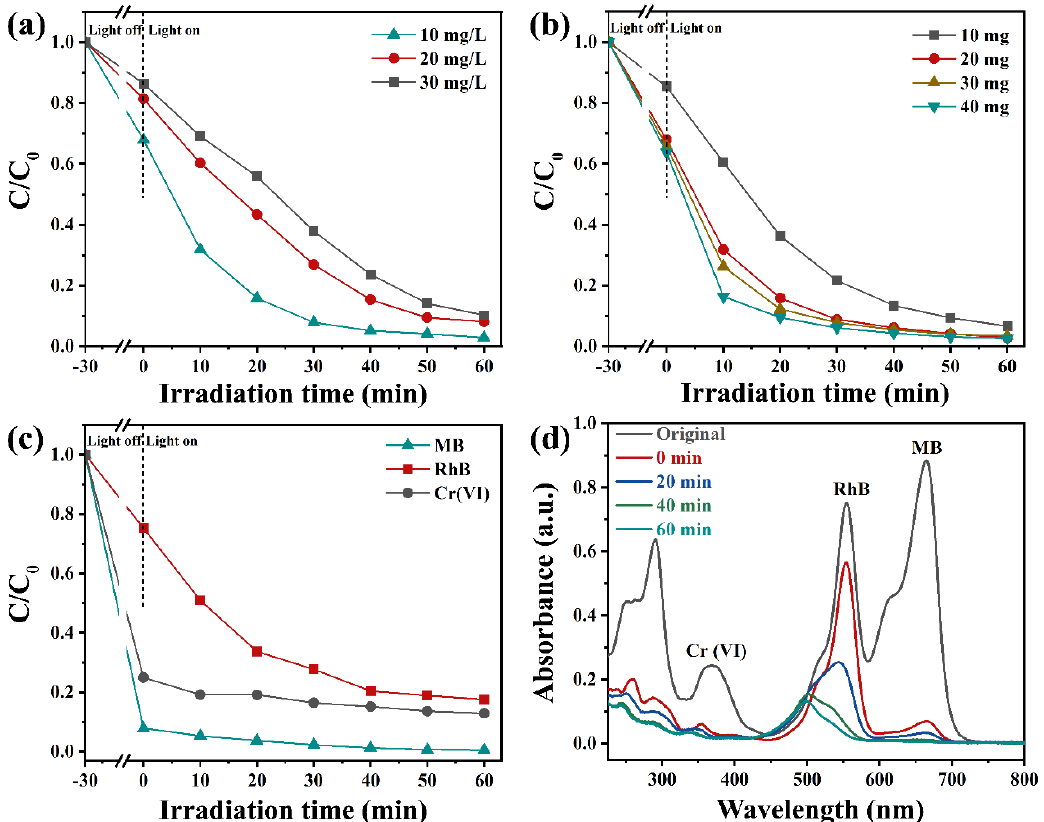
Figure 7. The removal efficiency of RhB solution by various concentrations of RhB ( a ), and various Vo-BiOBr/CdS dosage ( b ). Photodegradation efficiency of RhB-Cr(VI)-MB mixed solution over Vo-BiOBr/CdS ( c ), and time-dependent absorption spectra ( d ).